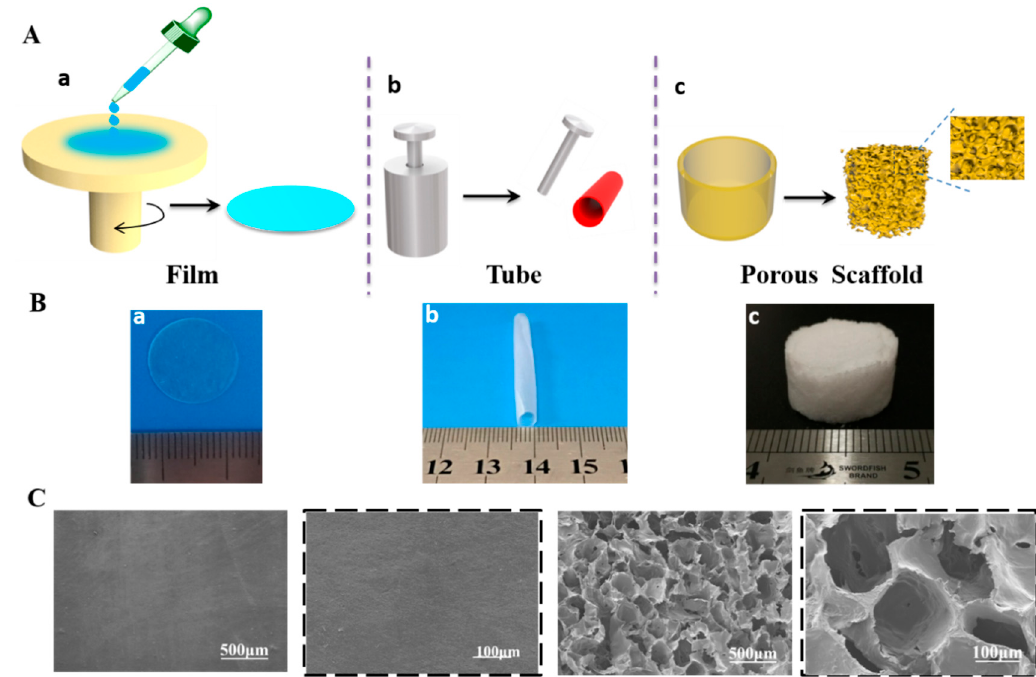
Figure 3. ( A ) Scheme for preparing polymer film, tube, and sca ff old using the solvent-free method. Figure 3. ( A )Scheme for preparing polymer film, tube, and scaffold using the solvent-free ( B ) Photos of the prepared film, tube, and sca ff old. ( C ) SEM of the prepared film and sca ff method. ( B )Photos of the prepared film, tube, and scaffold. ( C ) SEM of the prepared film and scaffold.